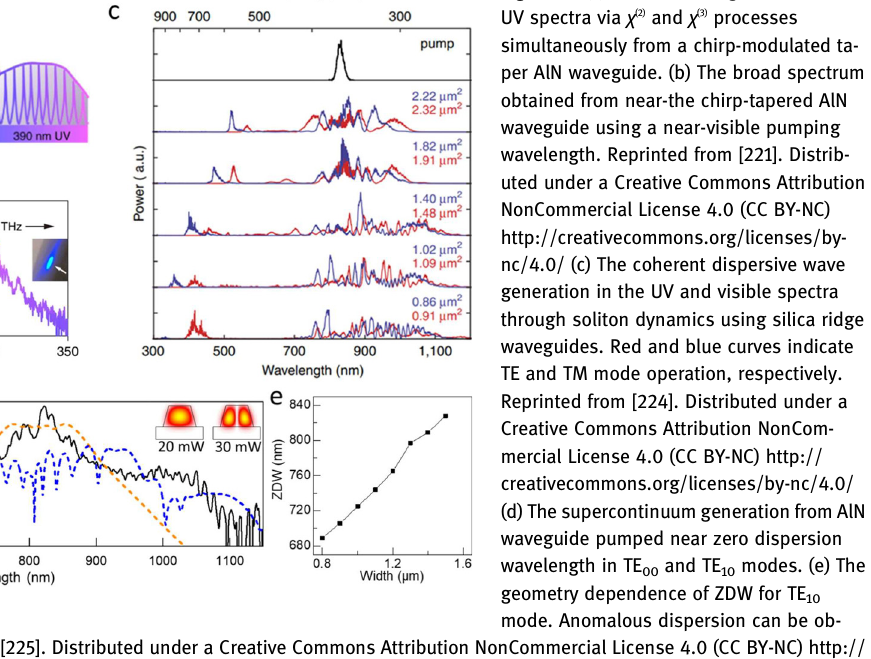
Figure 7: (a) The coherent generation in the UV spectra via χ (2) and χ (3) processes simultaneously from a chirp-modulated ta- per AlN waveguide. (b) The broad spectrum obtained from near-the chirp-tapered AlN waveguide using a near-visible pumping wavelength. Reprinted from [221].